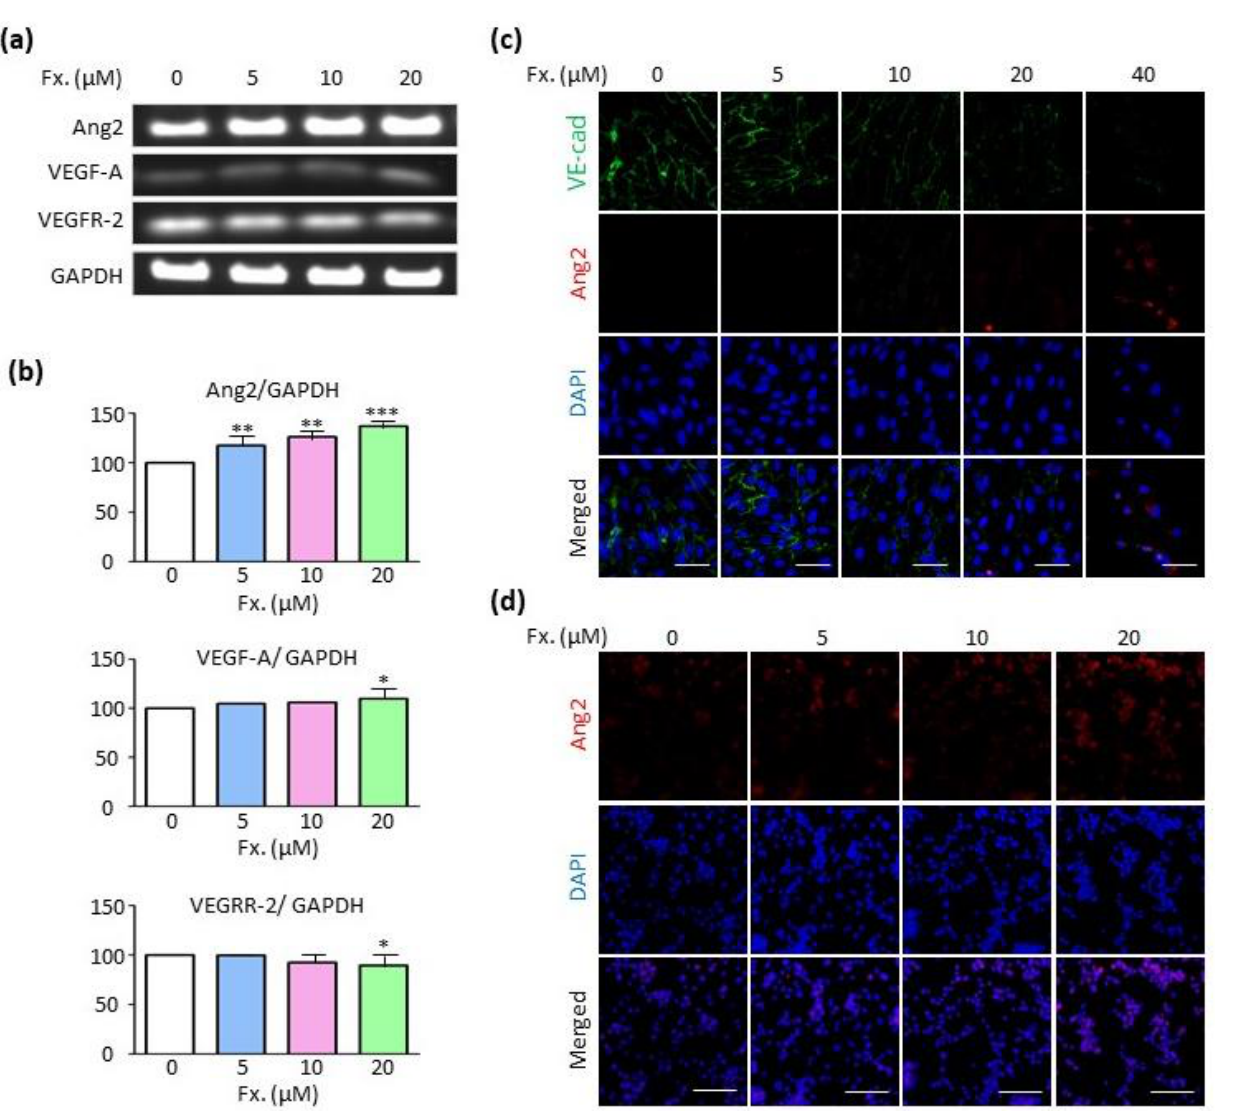
Figure 5. Fucoxanthin regulates Ang2 expression in the absence of VEGF-A/VEGFR-2 signaling pathway. ( a ) Images showing Ang2, VEGF-A, and VEGFR-2 mRNA expression in HUVECs after fucoxanthin treatment (0, 5, 10, and 20 µ M) for 24 h. ( b ) Relative density of Ang2, VEGF-A, VEFR-2 normalized by GAPDH. ( c , d ) Immunocytochemistry images showing Ang2 protein expression in HUVECs ( c ) and CMT-U27 cells ( d ) after fucoxanthin treatment at the indicated concentration for 24 h. Fx., Fucoxanthin. Values are presented as the mean ± SD of three independent experiments. * p < 0.05, ** p < 0.01, *** p < 0.001.